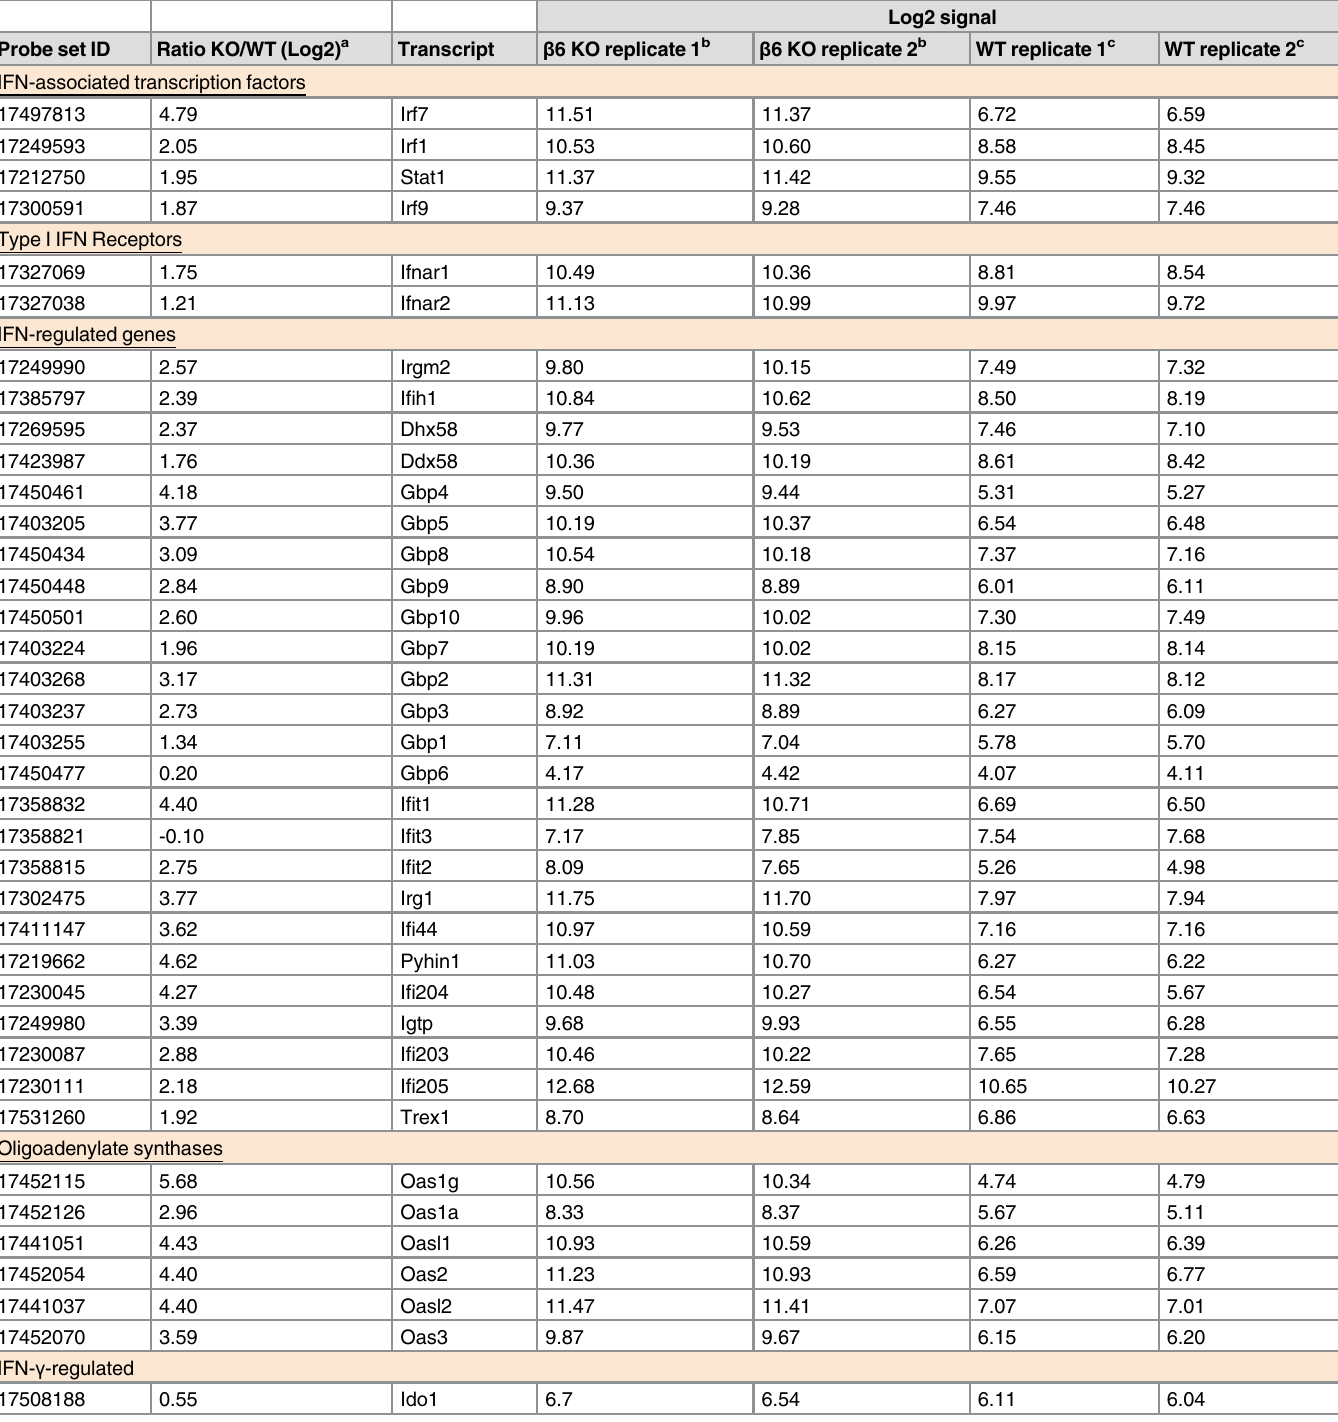
Table 1. Expression of genes associated with type I IFN responses in alveolar macrophages of WT and β 6 KO mice.